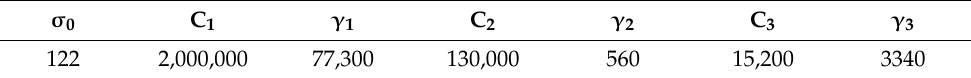
Figure 8. Results of a total strain increase at 240 °C test with 𝛥𝜀 𝑎,𝑡 = 0.05% and 𝜀 𝑎,𝑡,𝑠𝑡𝑎𝑟𝑡 = 0.05% (specimen 7.1): Material responses vs. time diagram. Table 2. Chaboche parameters for RT, determined using specimen NA01 at cycle 9941.